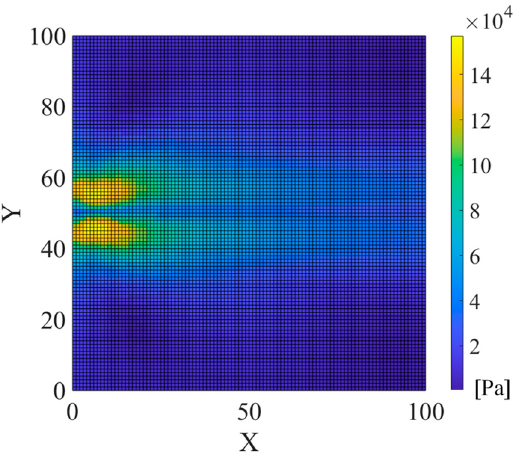
Figure 13. The distribution of pressure pulsation peak-to-peak value Δ P.